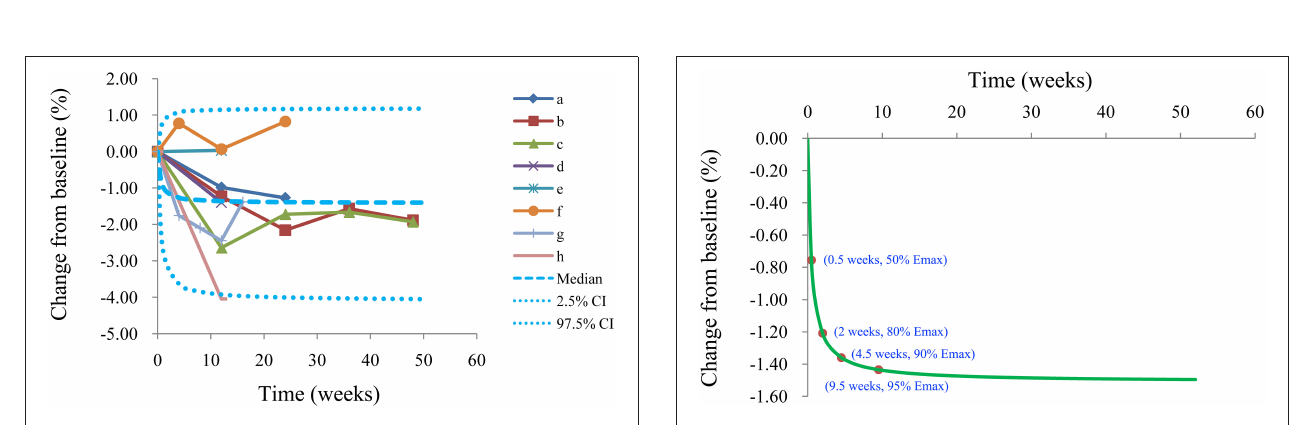
FIGURE 4 | Visual predictive check of the model from the l-carnitine effect on BMI. Median, 2.5% CI and 97.5% CI were simulated by Monte Carlo ( n = 1,000); CI, confidence interval; From a to h were studies come form El-Sheikh et al. (16), Derosa et al. (14), Derosa et al. (15), Malaguarnera et al. (13), Malaguarnera et al. (12), Galvano et al. (11), Derosa et al. (10), Liang et al. (9), respectively.